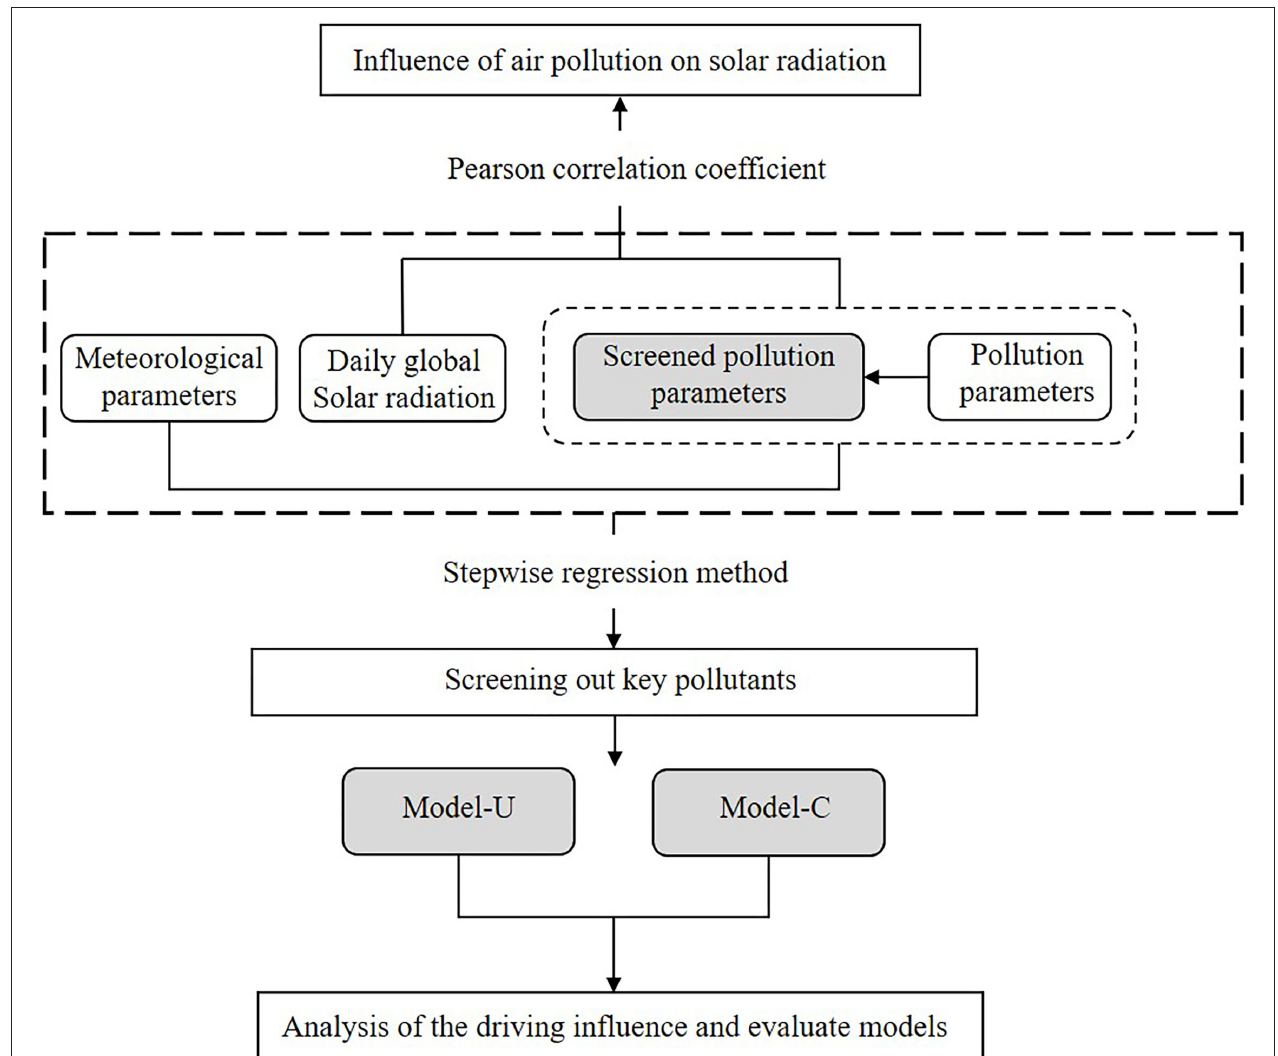
FIGURE 2 | Structure and technical framework of the